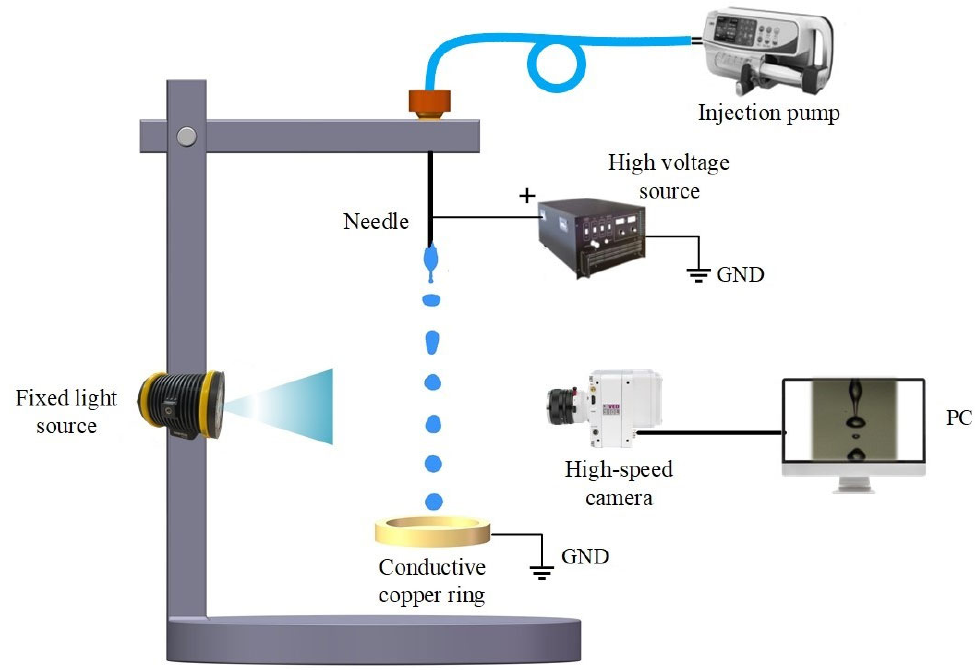
Figure 2. Schematic diagram of experimental setup.